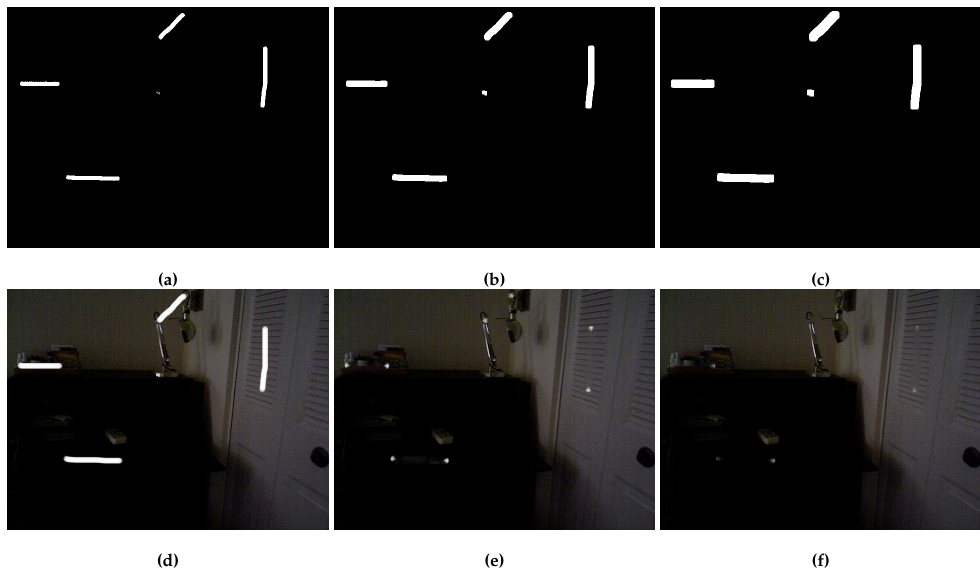
Figure 4. Results of the FMM combined with the image dilation. ( a ) Original mask. ( b ) The first dilation mask. ( c ) The second dilation mask. ( d ) Original image. ( e ) The first dilation result. ( f ) The second dilation result.